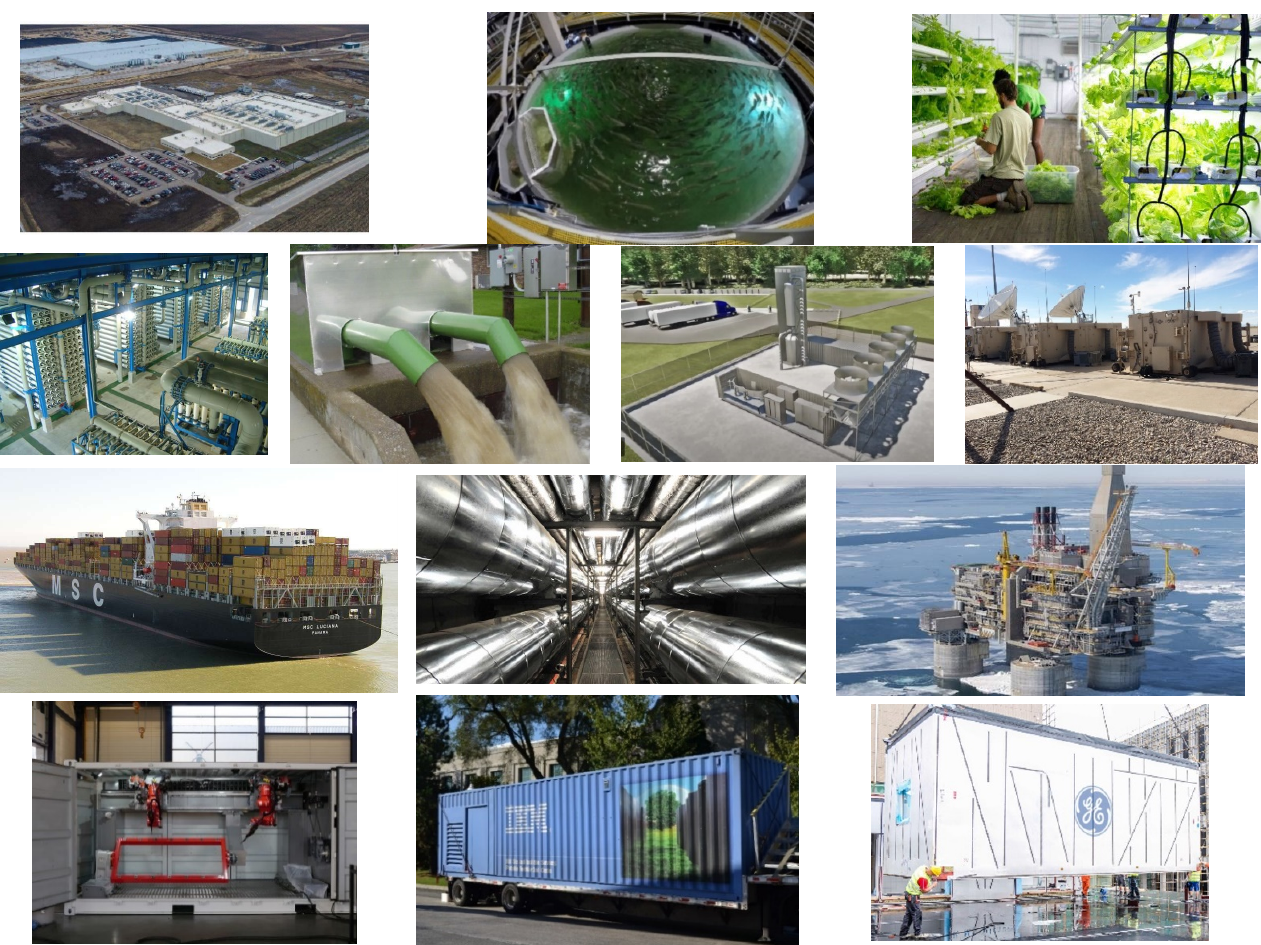
Figure 4. NBs could generate electricity and/or heat for myriad of collocated facilities. From top to bottom, left to right: process heat for factories, indoor aquaculture, containerized farming, water desalination units, pumps for flood protection, charging stations for e-trucks and hydrogen vehicles, military bases, freight ship propulsion, district heating, offshore oil/gas platforms, large 3D printing facilities, portable data centers and pharma manufacturing.